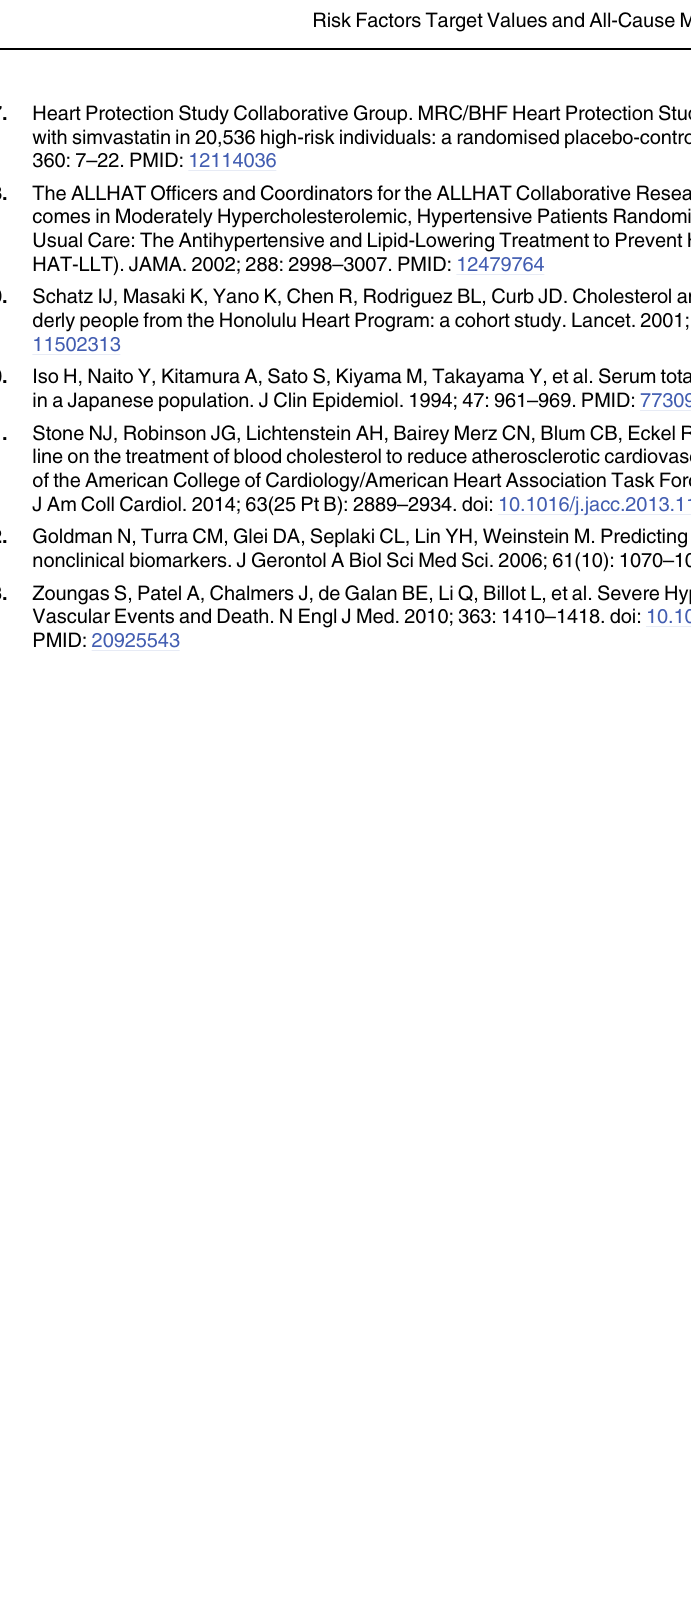
PLOS ONE | DOI:10.1371/journal.pone.0124536 April 30,